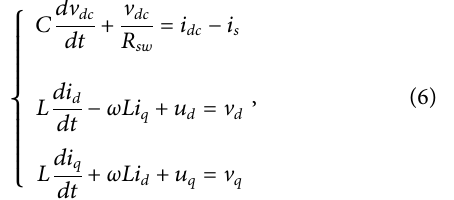
FIGURE 7 | Frequency characteristics of Z qq with and without power